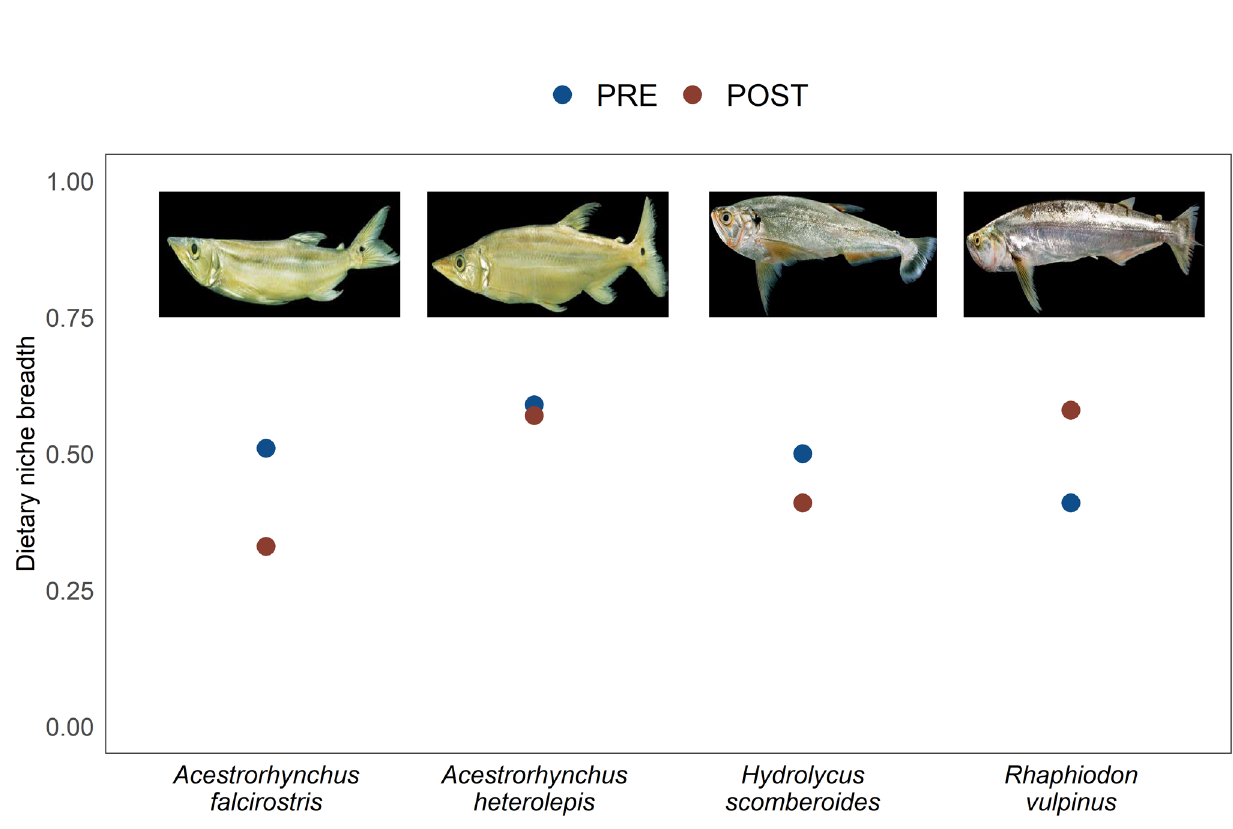
FIGURE 3 | Dietary niche breadth values of four piscivorous fishes before (pre-HPP) and after (post-HPP) dam construction in the Madeira River.